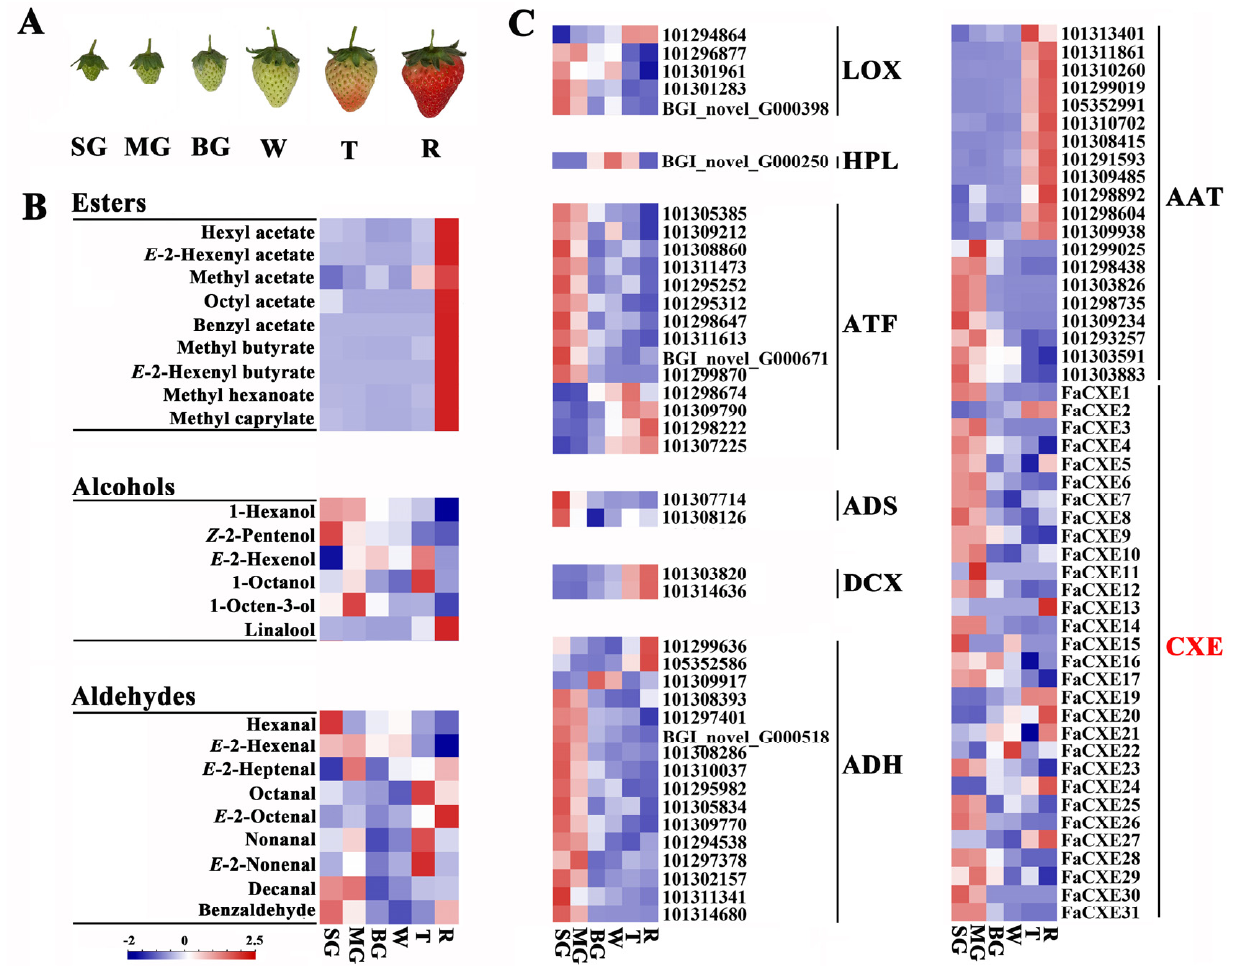
Figure 2. Accumulation pattern of substances and expression of genes involved in the metabolic pathway of volatile esters in strawberry fruits at different maturation stages. ( A ) Strawberry fruits at different maturation stages. ( B ) Heatmap in the contents of esters, alcohols and aldehydes at different maturation stages. ( C ) The expression pattern of genes involved in the metabolic pathway of aroma substances in strawberry fruits at different maturation stages.